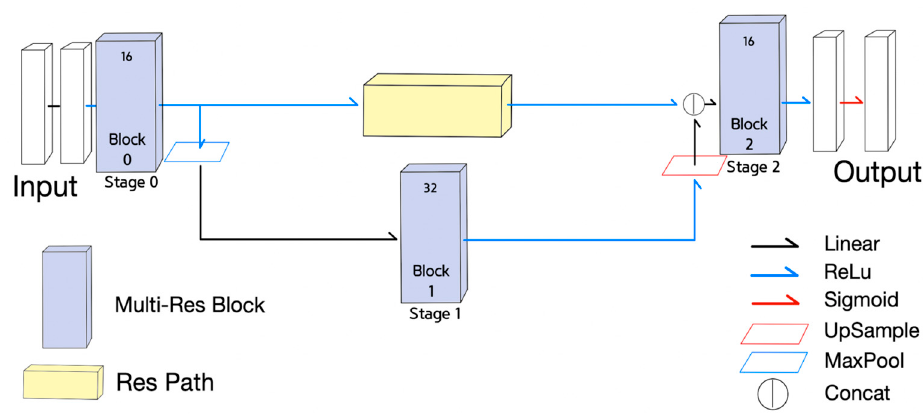
Figure 6. Quarter MultiResUNet.